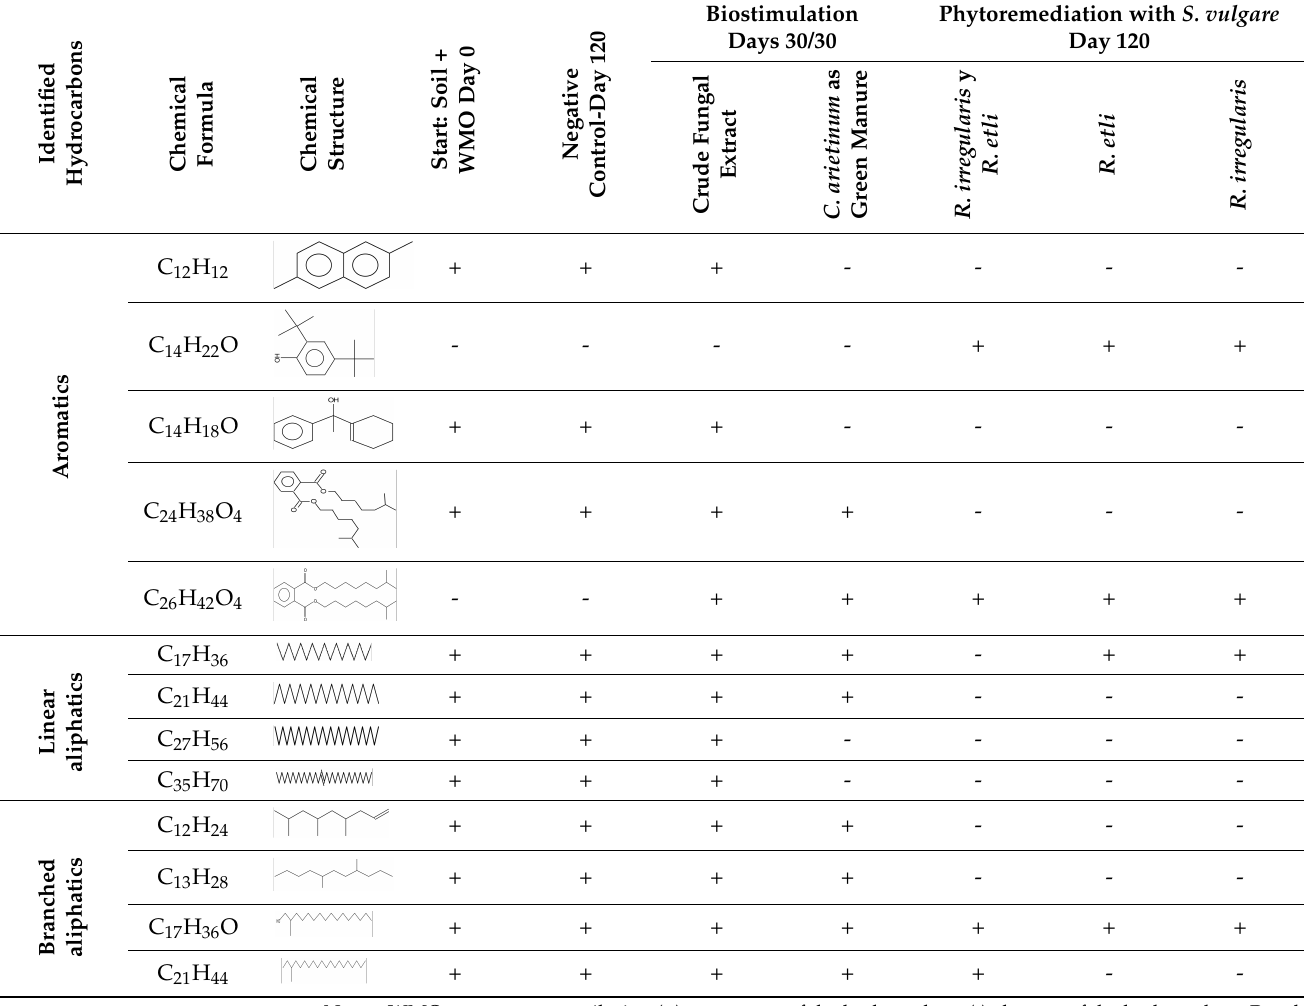
Table 1. Remnant hydrocarbons derived from mass coupled gas chromatography analysis of soil with 34,500 ppm of waste motor oil before and after biostimulation with a crude fungal extract, Cicer arietinum and phytoremediation with Sorghum vulgare inoculated with Rhizophagus irregularis and/or Rhizobium etli